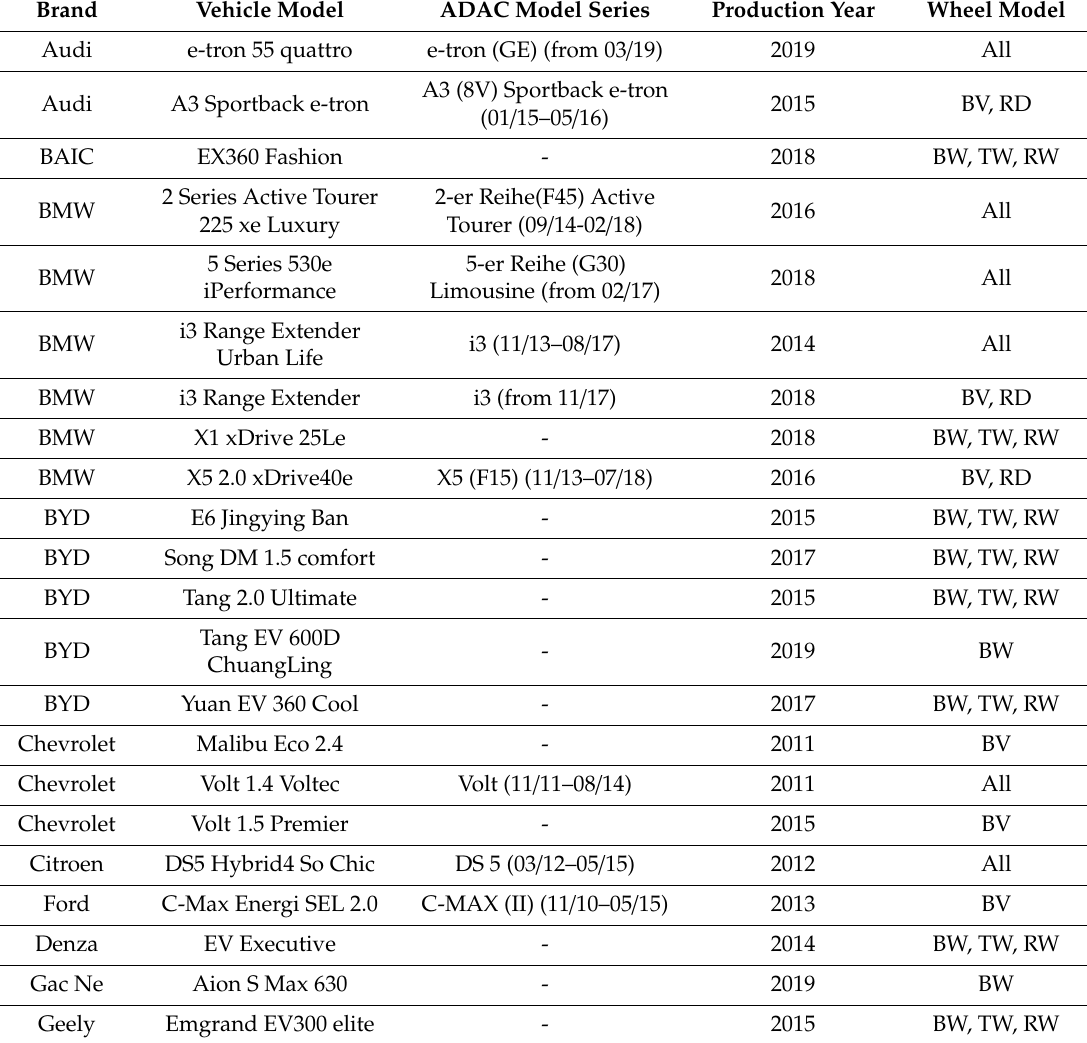
Table A1. Database overview, part